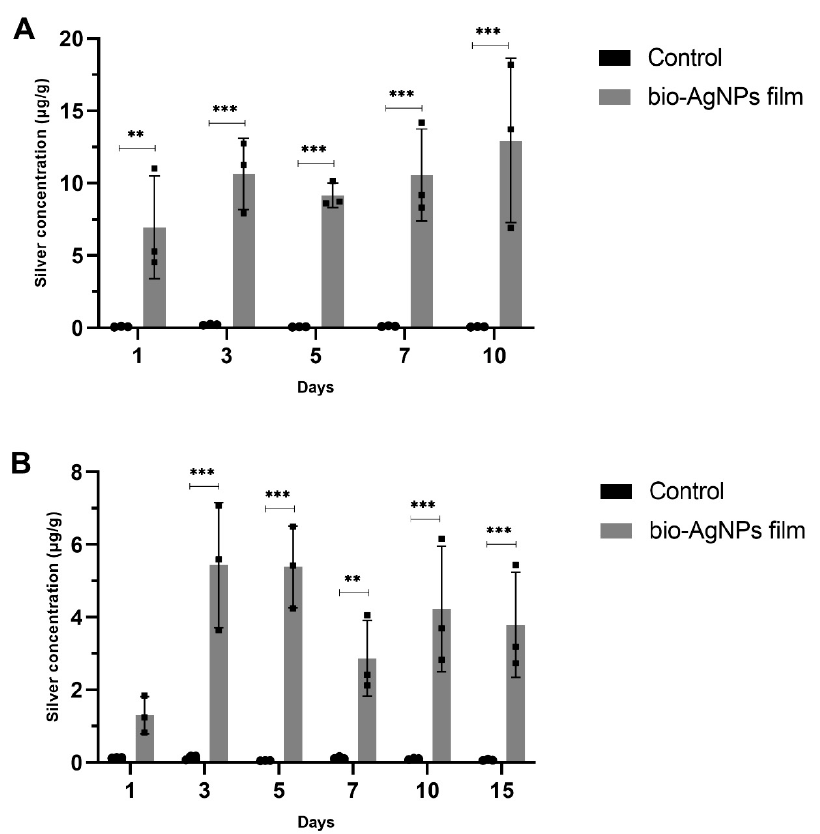
Figure 6. Quantification of silver migration from bio-AgNPs films to chicken meat pieces stored in the ( A ) refrigerator and ( B ) freezer. The data are expressed as the mean ± standard deviation of three replicates. Statistically significant differences between the groups were determined using an unpaired Student’s t -test. ** p < 0.01; *** p < 0.001 comparing control and bio-AgNPs film-treated groups. The control group indicates chicken pieces treated with films without bio-AgNPs.